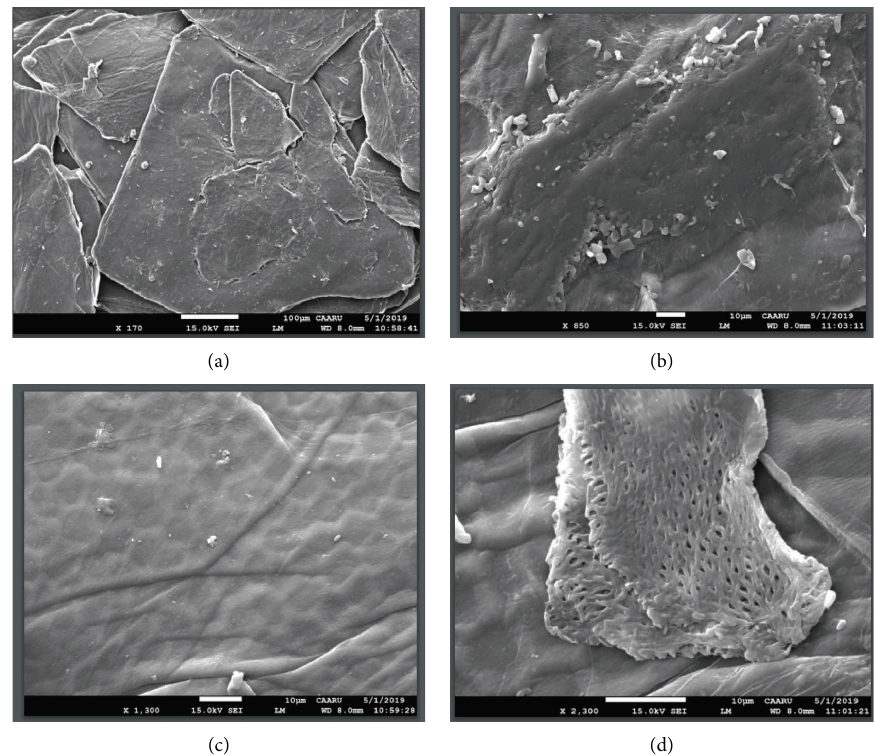
Figure 3: (a) SEM image of chitosan at × 170 (b) SEM image of chitosan at × 850 (c) SEM of chitosan image at × 1300 (d) SEM of chitosan image at ×